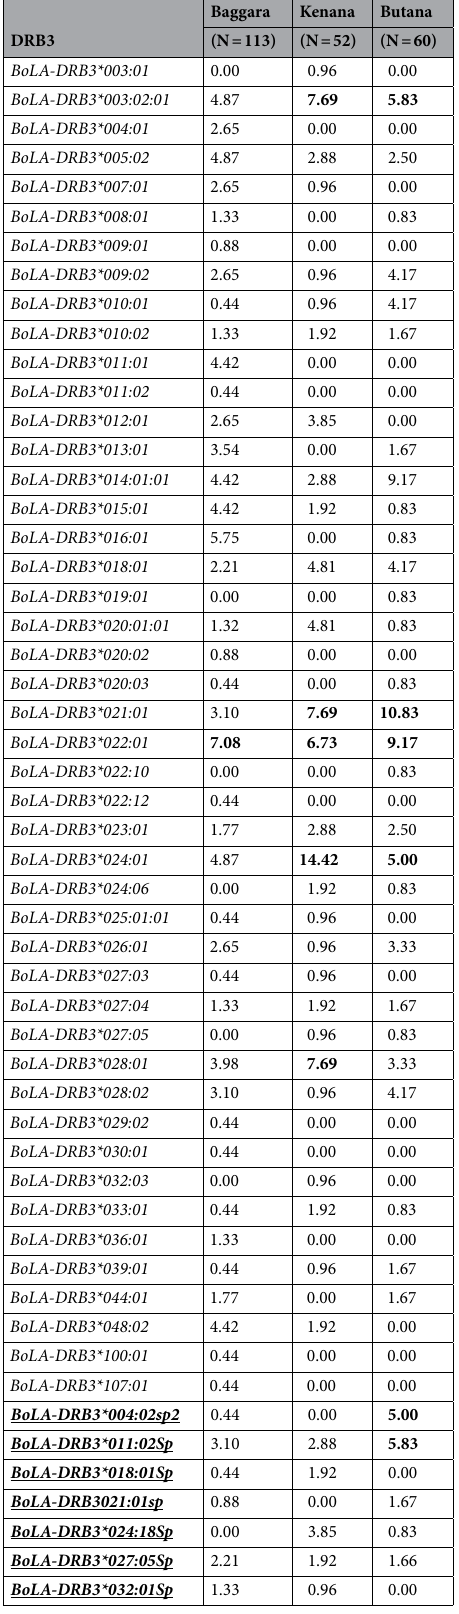
Table 1. BoLA-DRB3 allele frequencies (in percentage) in native Sudanese cattle breeds. N. number of animals analyzed; Frequent alleles in each breed are indicated in bold (> 5%); Novel alleles identified in this study are indicated in bold and